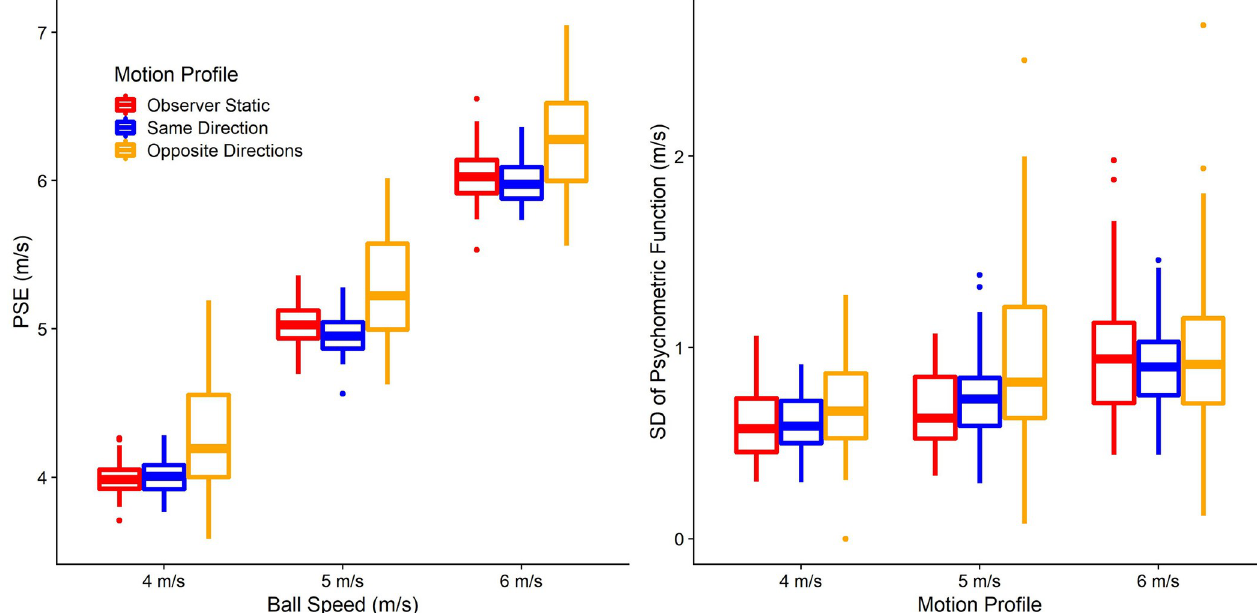
Fig 4. A. Predicted PSEs (y axis) for each ball speed (x axis) and motion profile (color-coded; left-most: “Observer Static”; in the middle: “Opposite Directions”; right-most “Same Directions”). B. As A. but for the predicted JNDs.